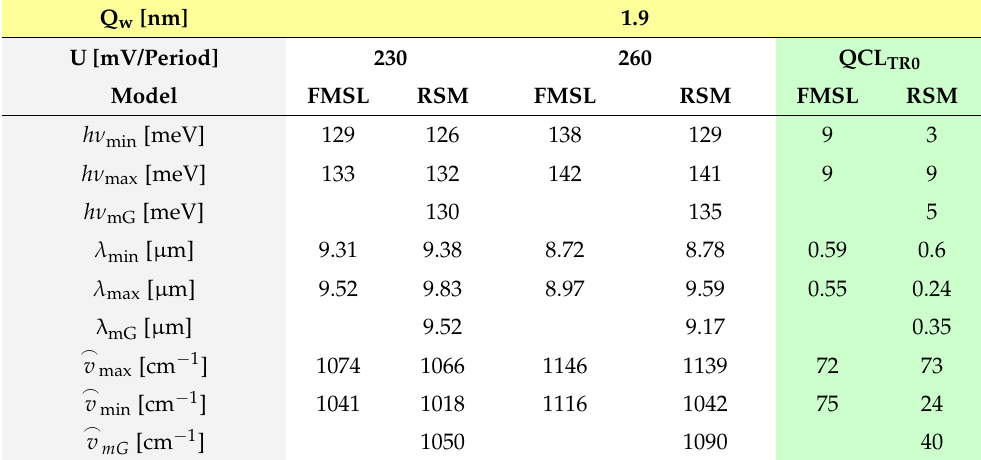
Table 2. QCL tuning range calculated for the simulation results presented in Figures